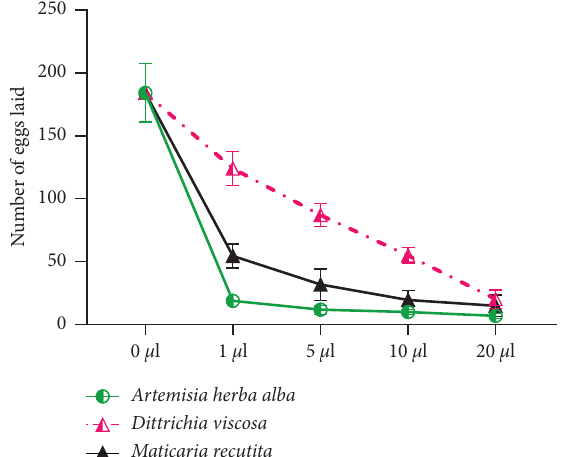
Figure 11: Effects of essential oils on the number of eggs laid by females of Callosobruchus maculatus Fab.